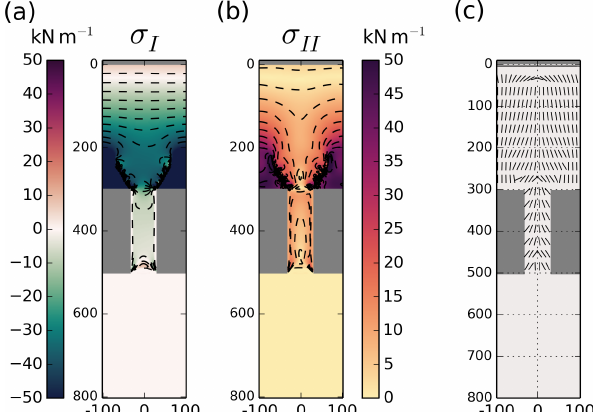
Figure 10. Stress fields during Phase E. (a) Normal stress invariant ( σ I ), (b) shear stress invariant ( σ I ) and (c) orientation of the second principal stress component.